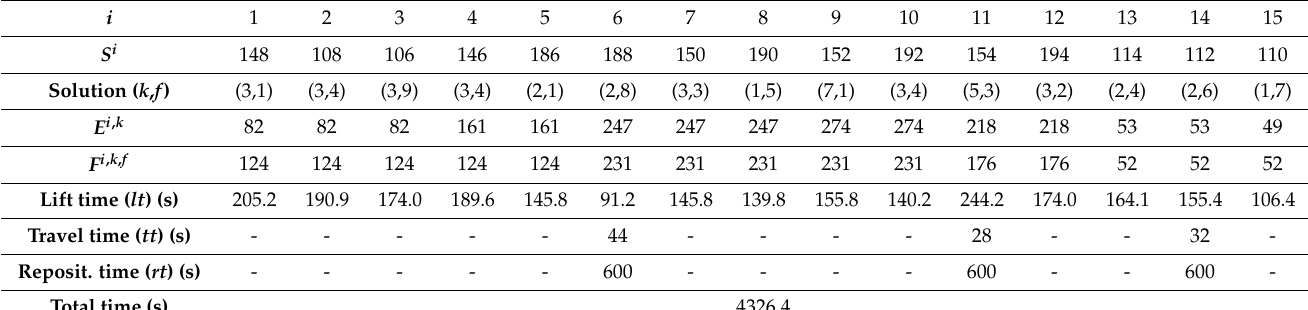
Table 1. Experimental